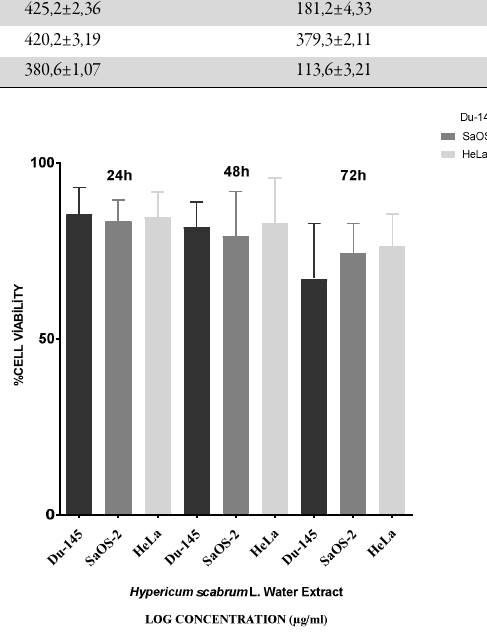
Fig. 2. Cytotoxity activities of water extract of Hypericum scabrum L. on Saos-2, HeLa and DU-145 cell lines